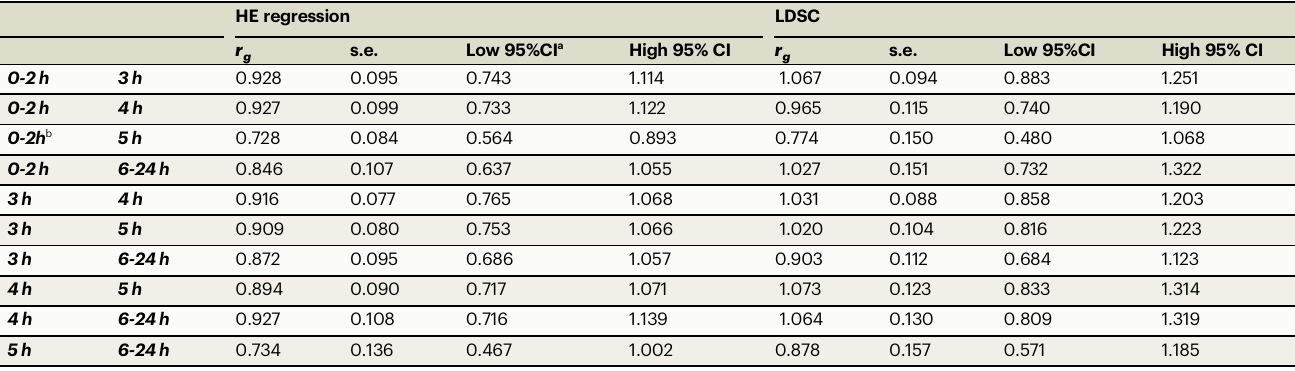
Table 1 | Genetic correlation estimates ( r ) between pairwise (fasting) subgroups, calculated using Haseman-Elston (HE) g regression analysis or LDSC analysis on unrelated samples only HE